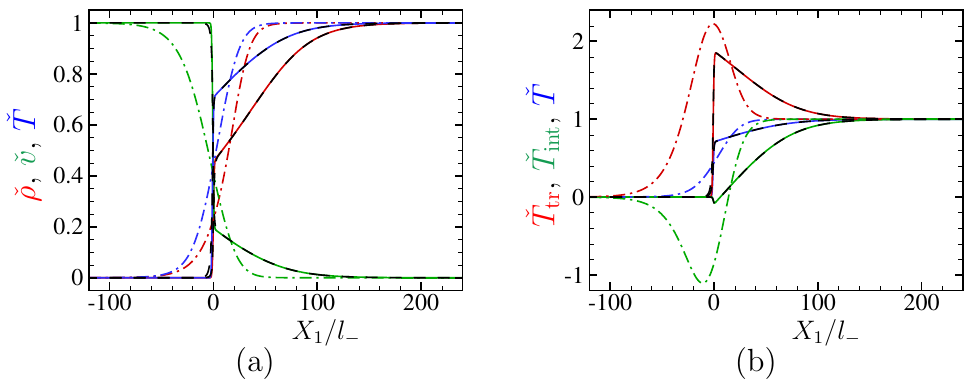
Figure 6. Profiles of ˇ ρ , ˇ v , ˇ T , ˇ T tr , and ˇ T int in the case of the pseudo-CO 2 gas at M − = 3 for µ b / µ = 100. ( a ) ˇ ρ , ˇ v , and ˇ T ; ( b ) ˇ T tr , ˇ T int , and ˇ T . See the caption of Figure 3.